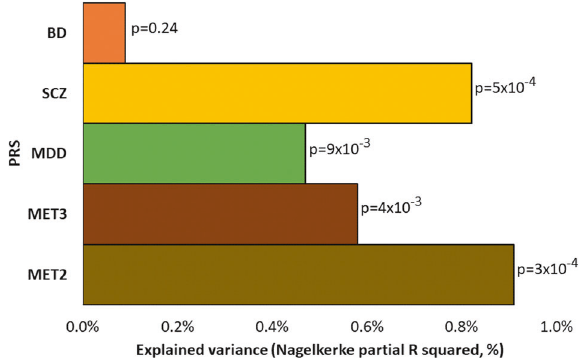
Fig. 1 The associations of polygenic risk scores (PRS) for bipolar disorder (BD), schizophrenia (SCZ), major depression (MDD), meta-SCZ/MDD/BD (MET3), and meta-SCZ/MDD (MET2) with dichotomous lithium treatment response (Alda total ≥ 7). The x - axis refers to the percentage of explained variance in treatment response to lithium accounted for by the PRS (Nagelkerke partial R 2 ). The y -axis plots the PRS for BD, SCZ, MDD, MET3, and MET2. Each bar is labelled with the p -values for the association between the PRS and lithium treatment